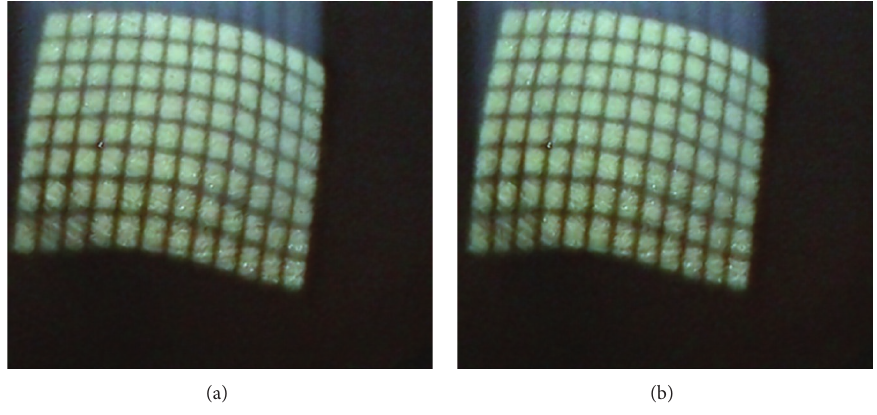
Figure 3: Original stereo endoscopic color images: (a) left image and (b) right image.